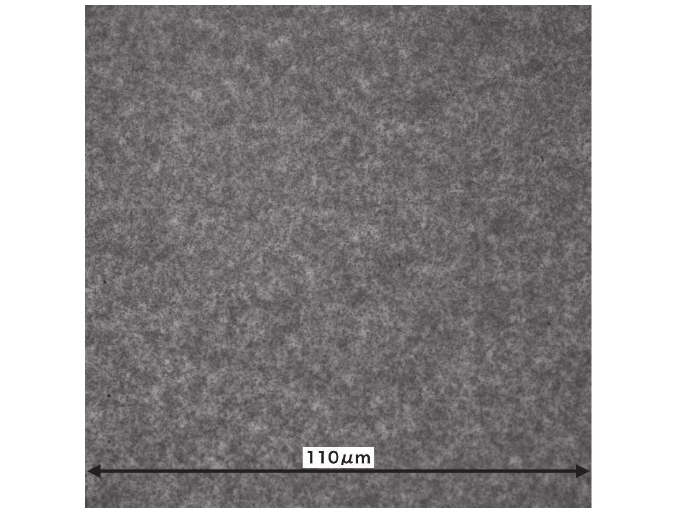
Figure 8. Expanded view of Figure 7. The silver grains are visible as black